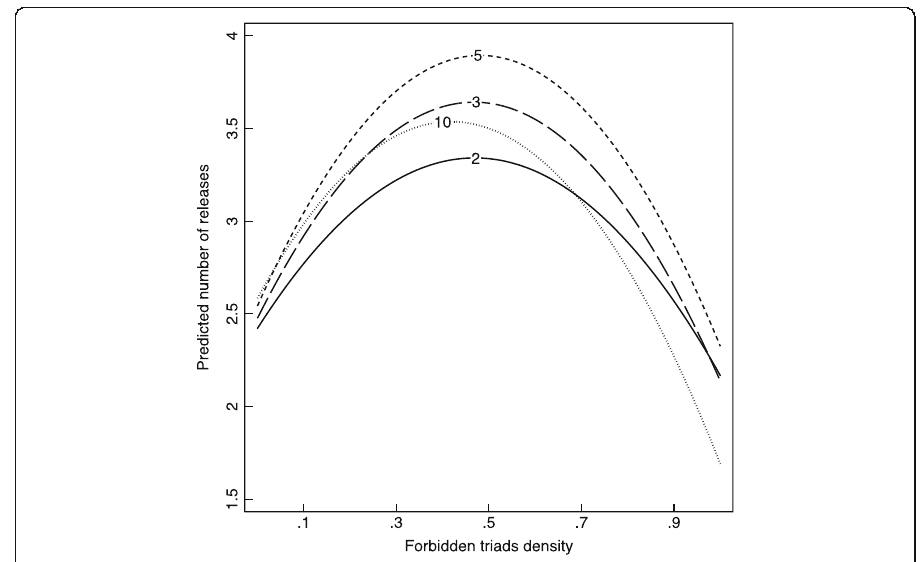
Fig. 11 Bivariate quadratic relationship between forbidden triads density and number of releases, with various thresholds for minimal triplet legs weight. Lines are labeled by the threshold value